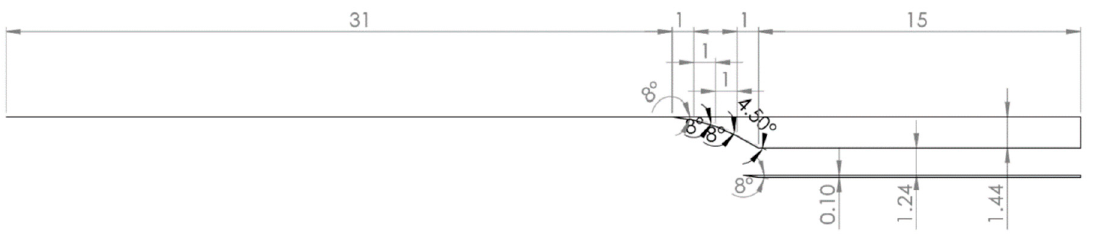
Figure 10. Four ramp inlet schematic (dimensions in metres). Table 4. Theoretical calculations for four ramp inlet.